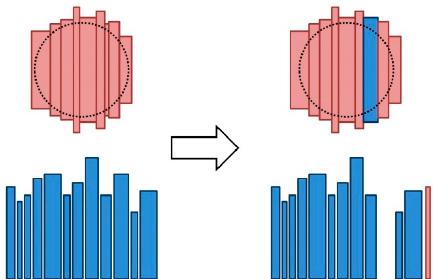
Figure 1. Procedure for applying the mutation operator to a head: one stave of the original head (represented in red) is randomly chosen, and it is replaced by a stave from the idle stave group (represented in blue) that complies the size requirements of the barrel head.